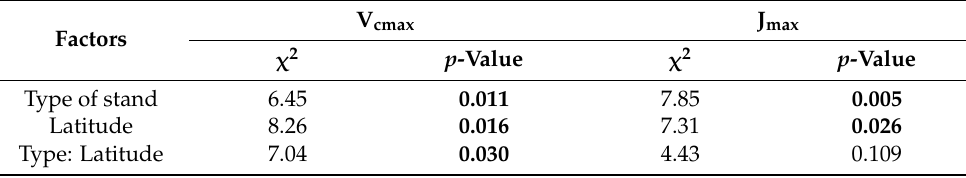
Table 2. Summary of ANOVA result (chi-square and p -value) of carboxylation (V cmax ) and electron transport (J max ) rates. Bolded p -value indicates a significant difference at the 5% threshold. Factors